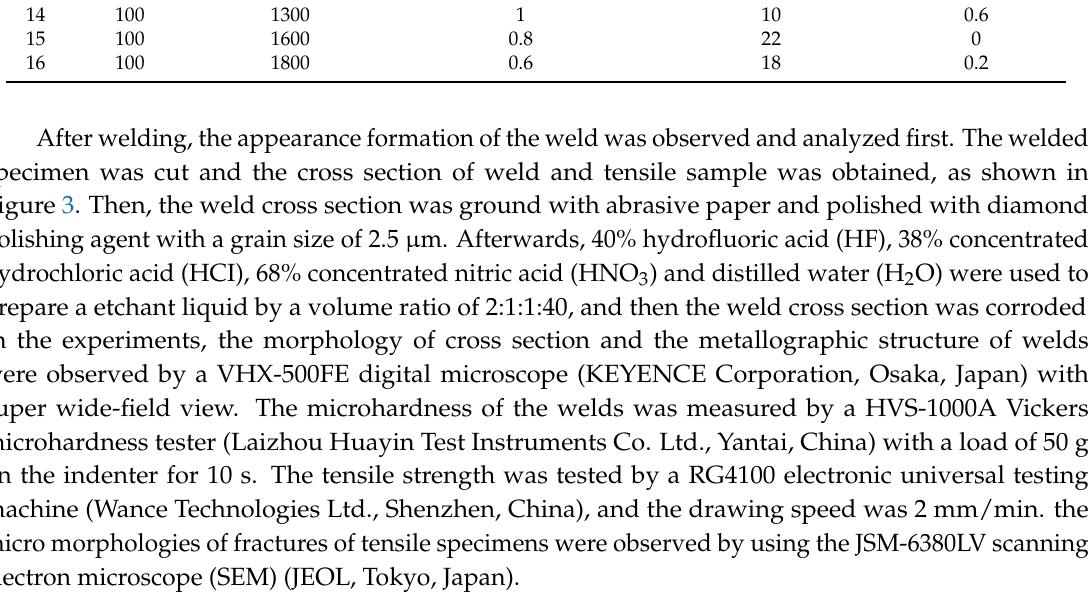
Table 2. Standard orthogonal test table.